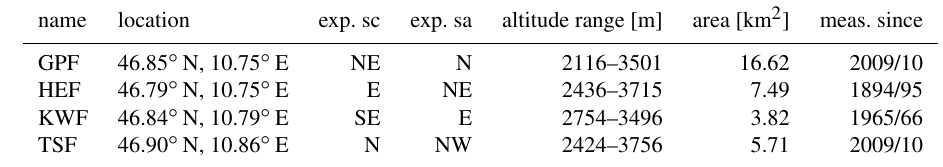
Table 1. Geographic location and characteristic numbers of GPF, HEF, KWF and TSF from Austrian Glacier Inventory 3 of 2006 (Fischer et al., 2015) and the year of the start of velocity measurements (meas. since). exp: exposition; sc: accumulation area; sa: ablation